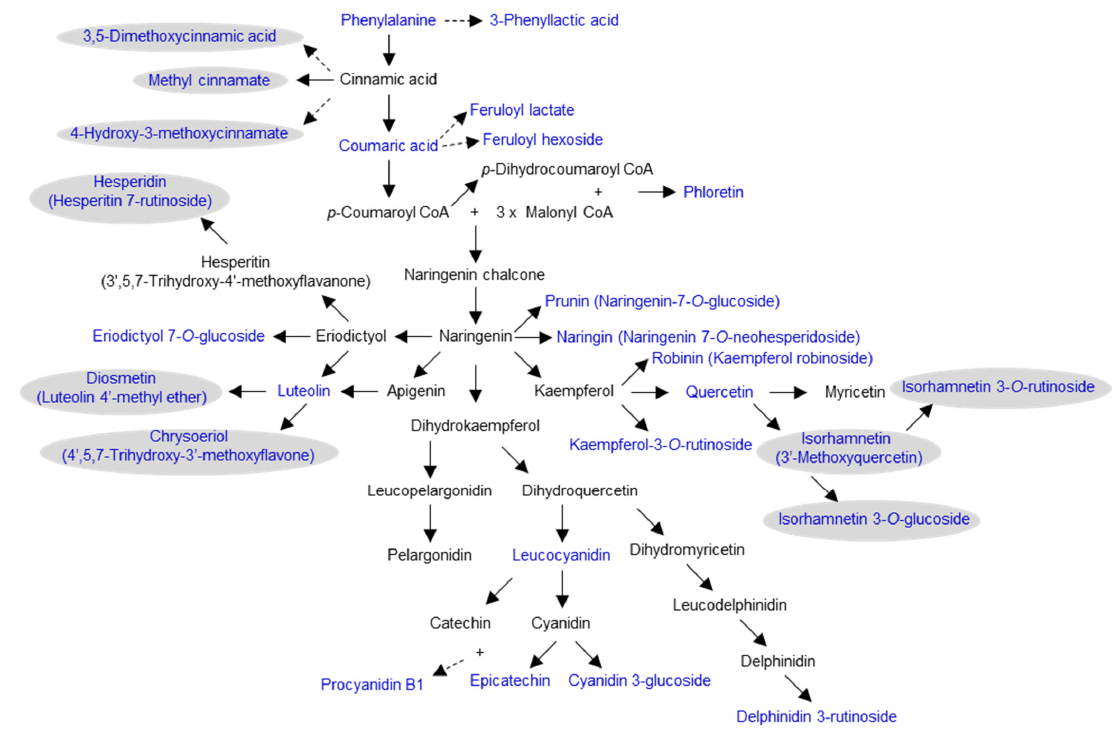
Figure 2. A simplified scheme of the general phenylpropanoid, flavonoid, anthocyanin, and proanthocyanidin biosynthetic pathways in Amborella trichopoda . These aglycones lead to the formation of diverse glycosidic derivatives (Tables S1–S3). Metabolites present in Amborella leaves are shown in blue, and methylated compounds are shaded in gray. Dotted arrows denote multiple enzymatic